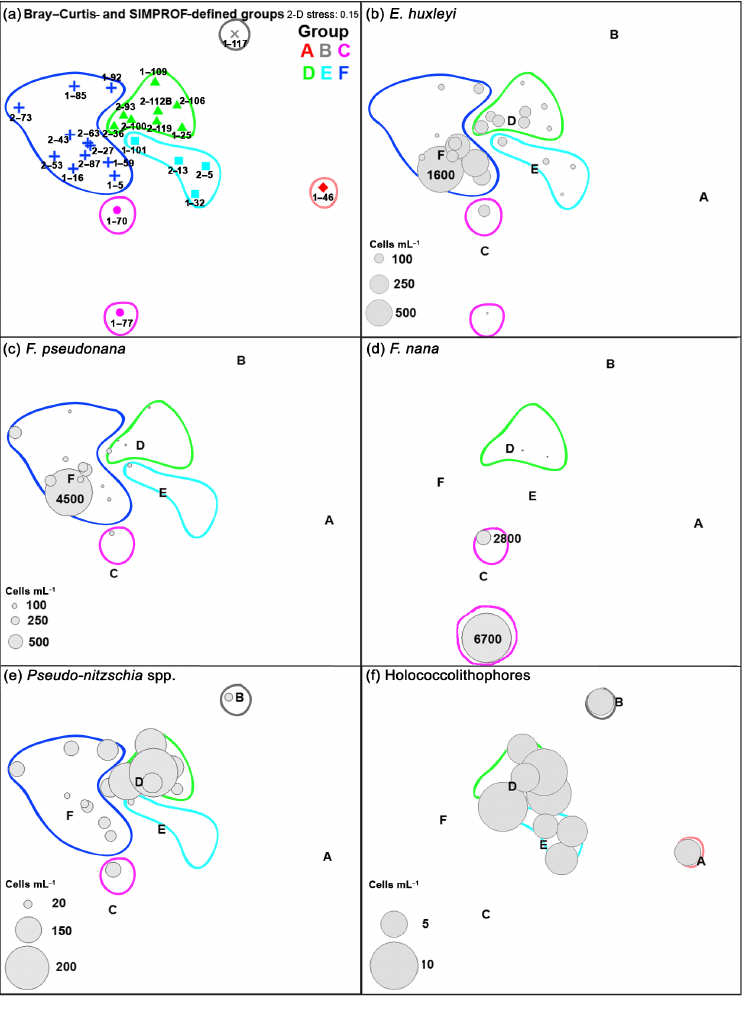
Figure 5. Two-dimensional nonmetric multidimensional scaling (nMDS) ordination of station groupings (a) as defined by the SIMPROF routine, with group color identifiers as in Fig. 3; relative distances between samples represent the similarity of species composition between phytoplankton communities. Stations with statistically similar species composition are clustered together, whereas stations with low statistical similarity in terms of species composition are more widely spaced. Overlay of bubble plots of the defining species abundance (cellsmL − 1 ) characterizing the statistically significant groups in the GCB (see also Table 4): (b) E. huxleyi abundance, (c) F. pseudonana abundance, (d) F. nana abundance, (e) Pseudo-nitzschia spp. abundance, and (f) Holococcolithophore abundance. The two-dimensional stress of 0.15 gives a “reasonable” representation of the data in a 2-D space (Clarke and Warwick,